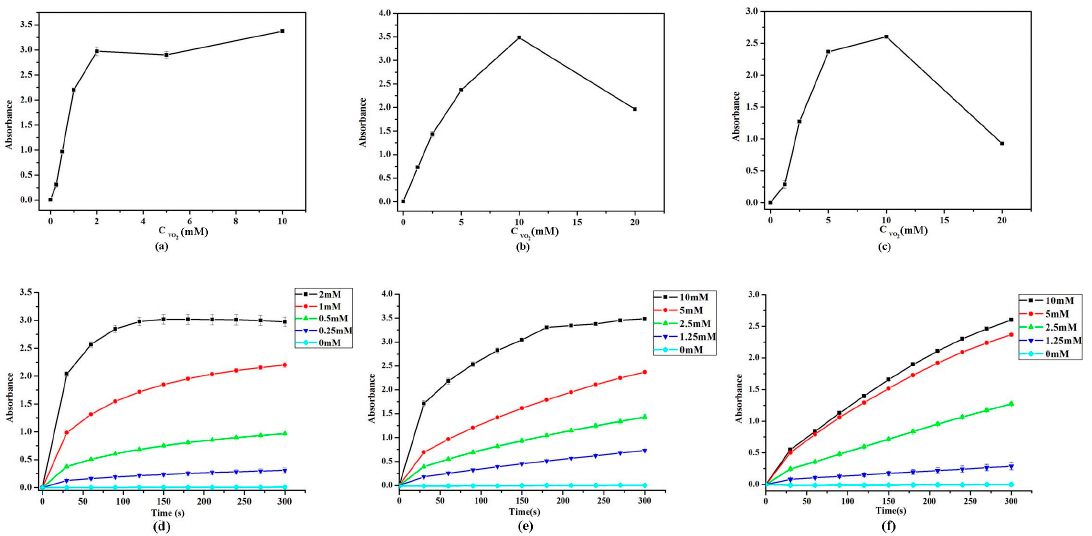
Figure 6. The effect of VO 2 nanofibers ( a , d ); VO 2 nanosheets ( b , e ); and VO 2 nanorods ( c , f ) concentrations on absorption value with TMB in pH 4.0 citrate buffer solution. The error bars represent the standard deviation of three measurements.